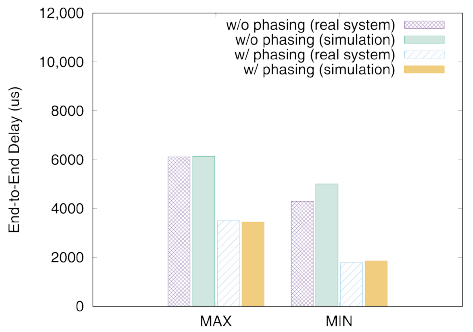
Figure 20. Max and min D e 2 e of VC 1 in test set 2.